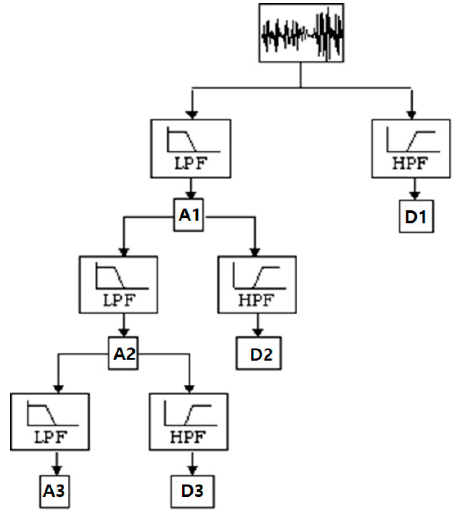
Figure 1. Filter bank representation of the discrete wavelet transform. LPF: Low Pass Filter; HPF: High Pass Filter.